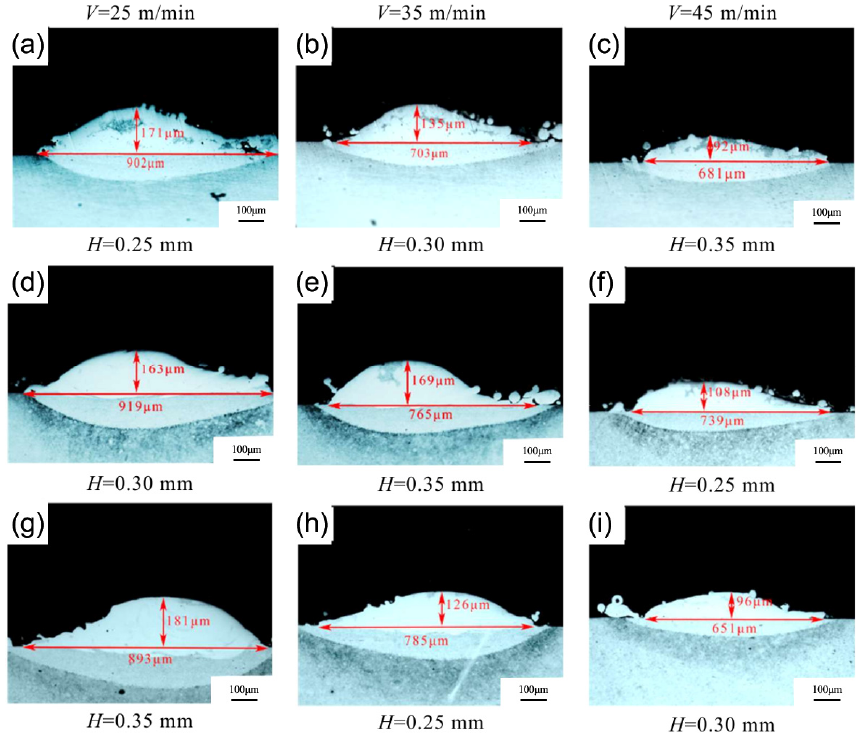
Figure 10. Specimen cross-sectional shape: ( a – c ) P = 1500 W; ( d – f ) P = 1700 W; ( g – i ) P = 1900 W [57]. In addition to M2 HSS, various HSS powders, such as Fe-Co-Mo HSS powder and high vanadium HSS powder, can be utilized to increase the surface hardness of a sub- strate. Xiong et al. [36] developed Fe-Co-Mo HSS coatings on 40Cr substrates with water- atomized alloy powder as the raw material using the simultaneous powder-feeding laser cladding approach. After post-treatment, the coatings’ hardness could reach 900~950 HV 0.2 . Rahmana et al. [37] laser-melted HSS material onto the surface of 42CrMo4 and discovered that the addition of Co elements to Fe-Cr-Mo-W-V sacrificed Fe (Fe bal-x -Cr-Mo- W-V-Co x ), which significantly boosted the coating’s overall hardness. Different carbides present in the laser cladded HSS alloys are shown in Figure 11. EDS maps and a BSE image revealed that MC carbides are rich in V and have blocky, circular, and rod-like shapes (VC). M 2 C carbides have a feathery, lamellar, and layered morphology and are enriched with Mo (Mo 2 C), Mo-containing carbides (Mo 2 C) have a crystalline structure. Fine Cr-en- riched secondary precipitates of M 7 C 3 and M 23 C 6 are interspersed throughout the matrix.